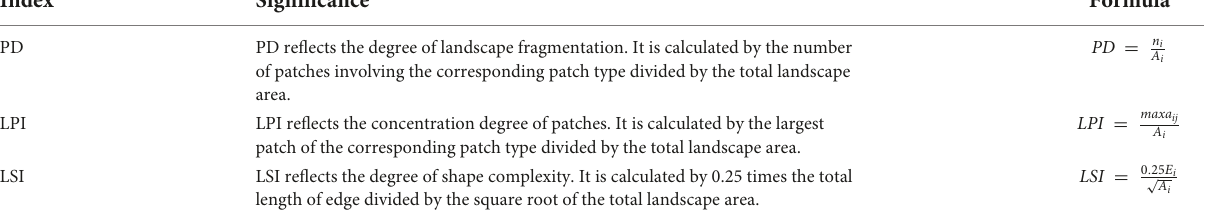
TABLE 1 Description of land-use dominant morphology